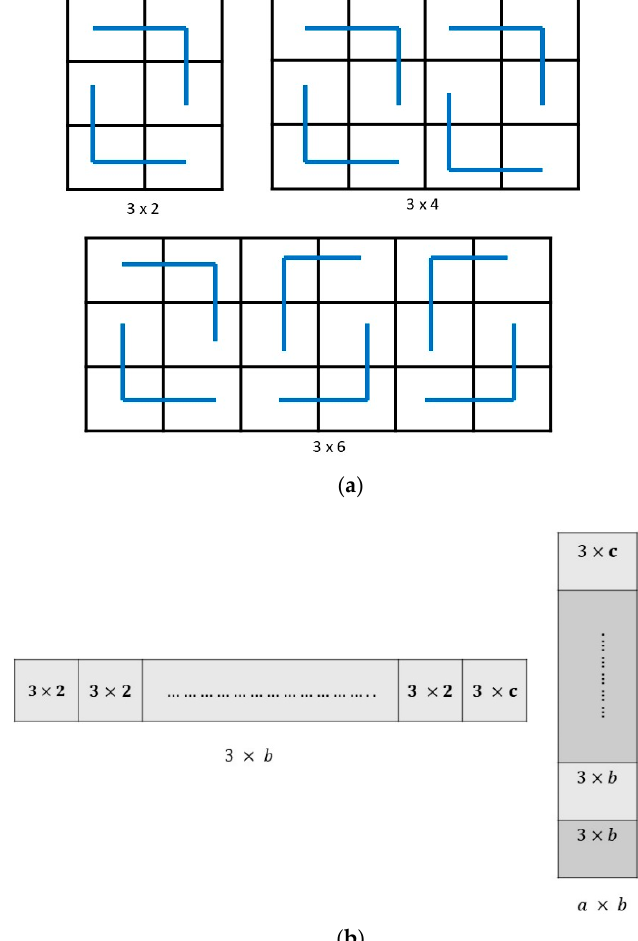
Figure 3. Image Argument for Lemma 1. ( a ) a = 3 and b is even; ( b ) Decomposing a × b rectangle into sub-rectangles.